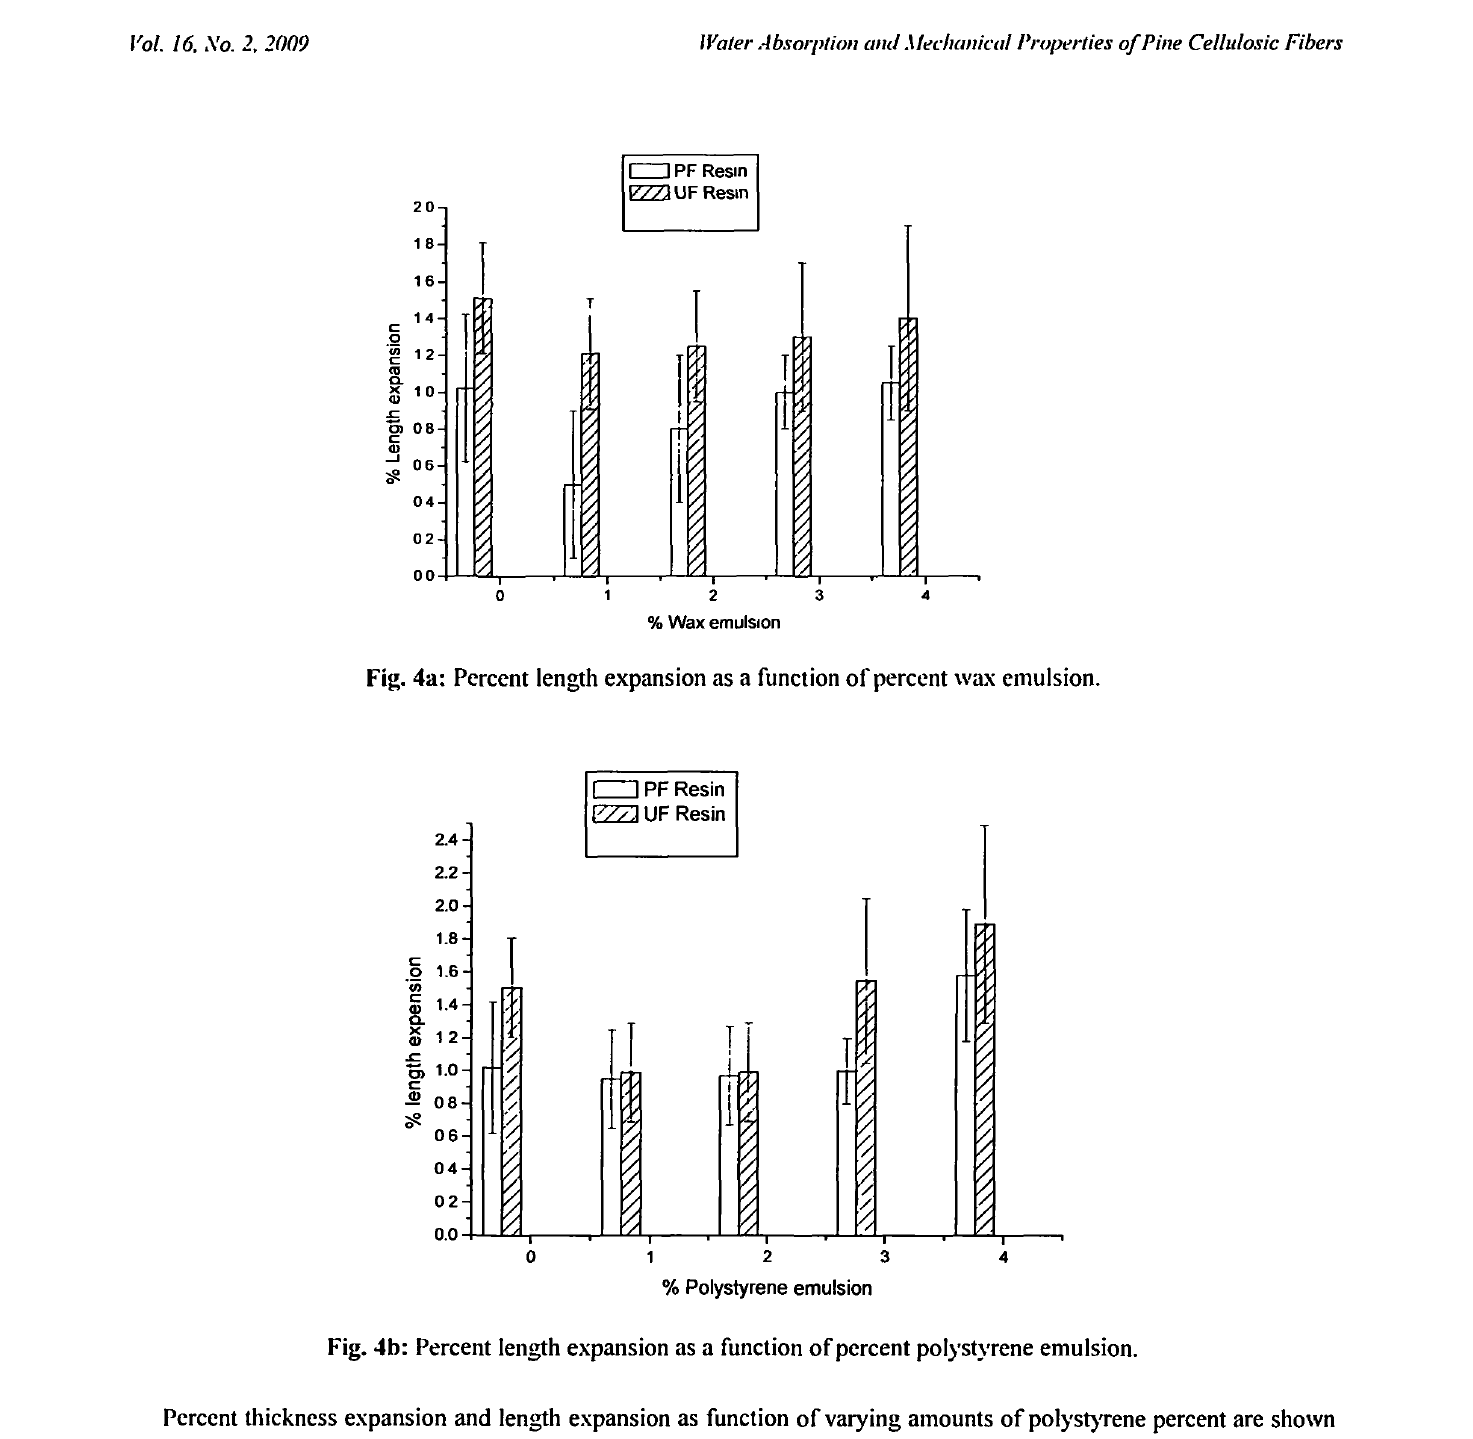
Fig. 4b: Percent length expansion as a function of percent polystyrene